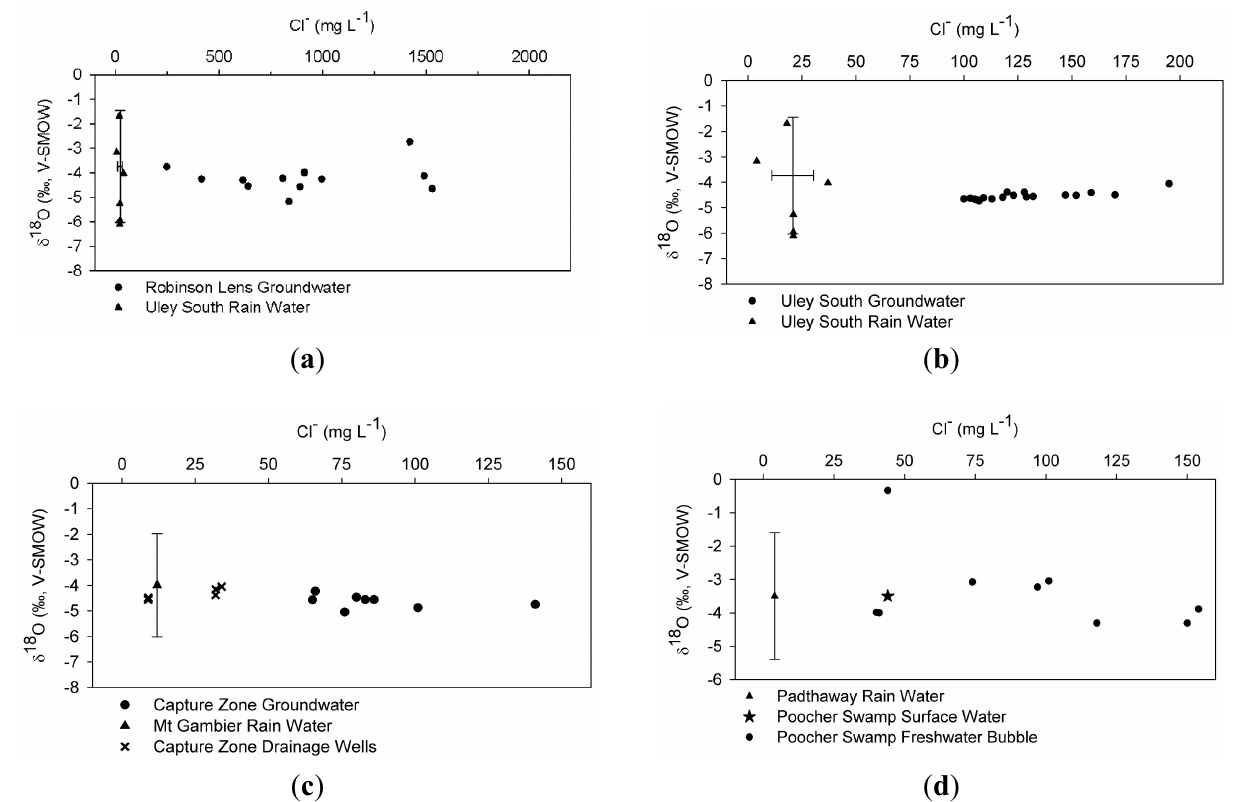
Figure 15. Chloride vs. 18 O for point recharge dominant groundwater basins ( a ) Robinson lens ( b ) Uley South ( c ) Mount Gambier Blue Lake capture zone ( d ) Poocher Swamp fresh water